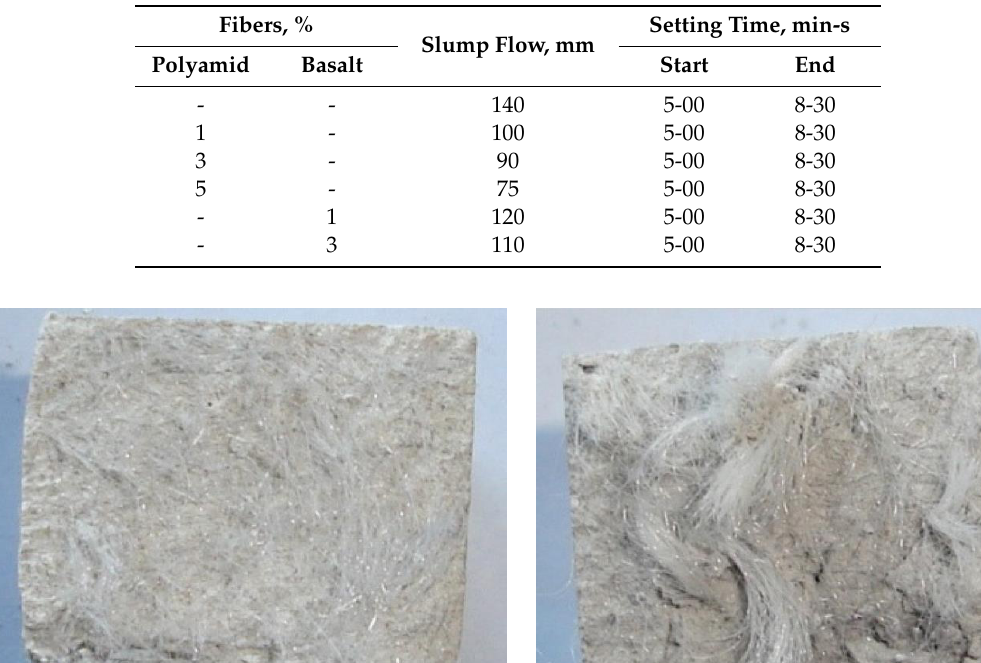
Table 8. E ff ect of microfiber on the properties of the hardened GCB-FA.